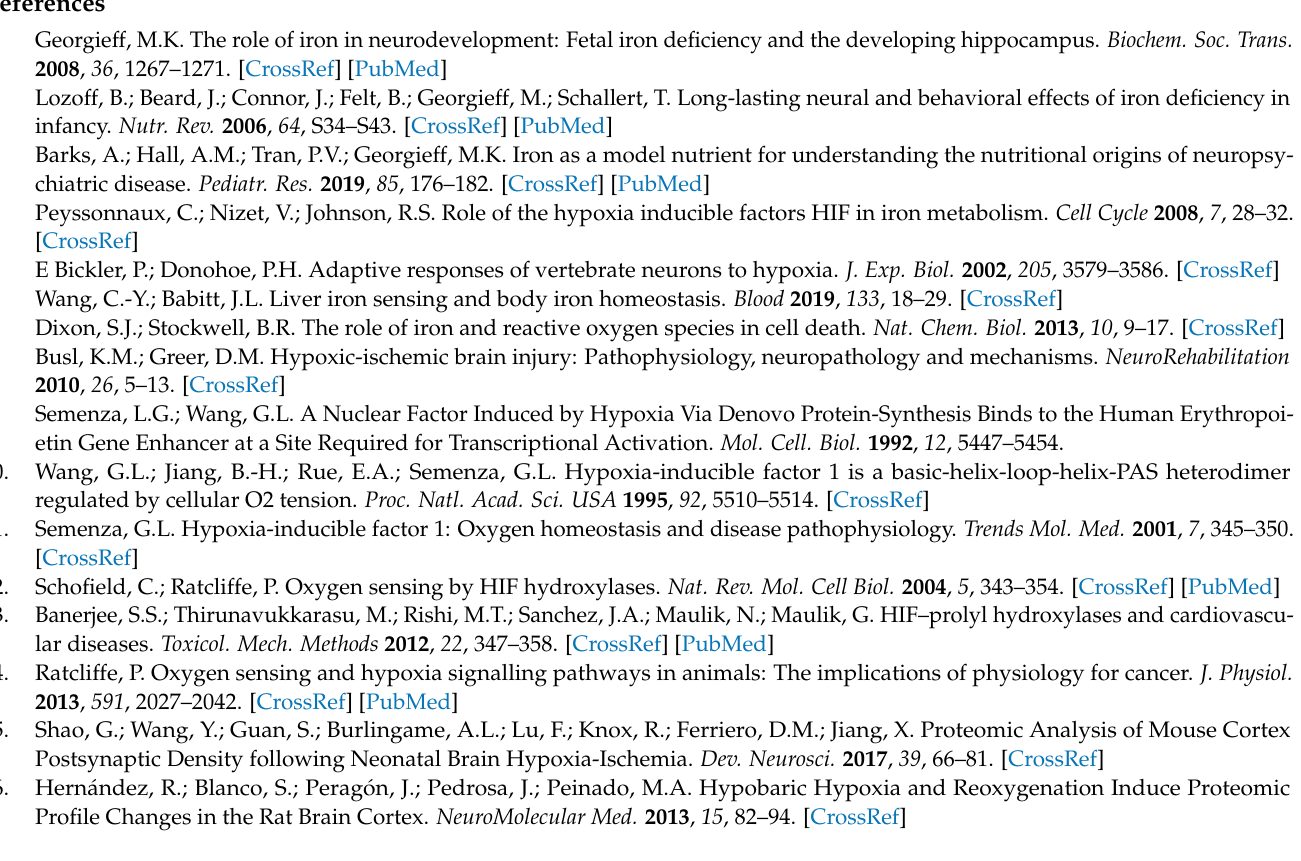
Table S2: HIF1a targets quantitation in hypoxia and DFO, The list of known transcriptional targets of hypoxia-inducible factor 1 alpha and corresponding quantification upon hypoxia, acute and chronic iron deficiency treatment, Table S3: Gene Ontology Annotation for (A) Biological Process, (B) KEGG Pathways, (C) Molecular Functions, (D) PFAM Analysis, Table S4: P15 microarray raw data, Quantification of gene expression profiles with microarray analysis on P15 rat hippocampus tissue upon iron deficiency